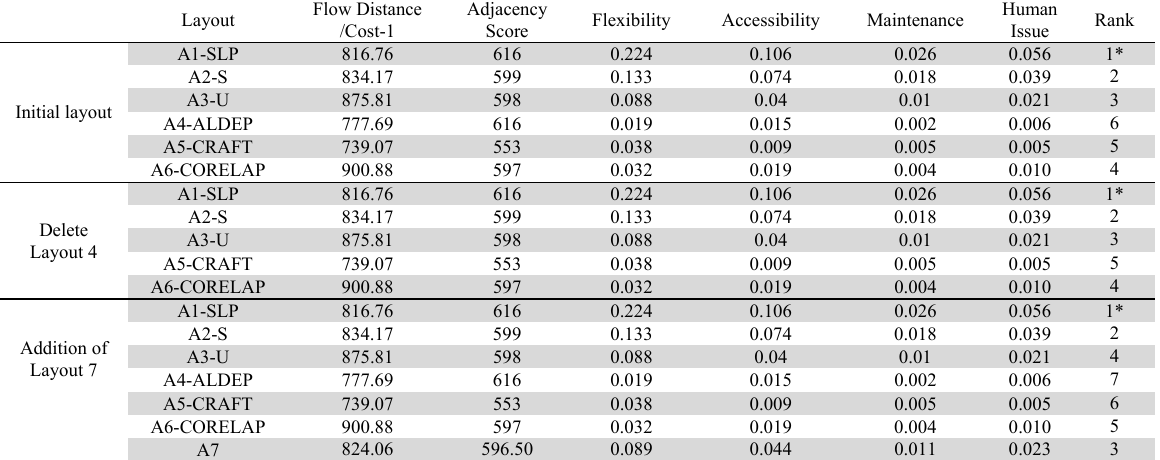
Initial and other combination values by considering Max-Min normalization method